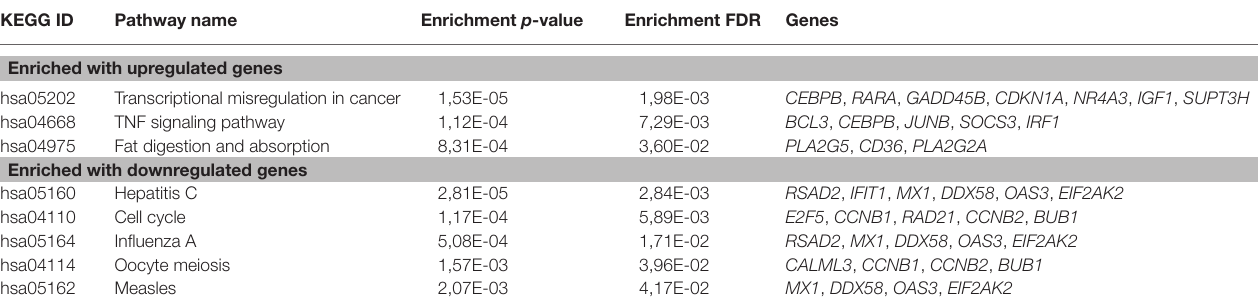
TABLE 1 | Kyoto Encyclopedia of Genes and Genomes (KEGG) pathways that are significantly enriched with genes associated with progression-free survival (PFS) in locally advanced prostate cancer